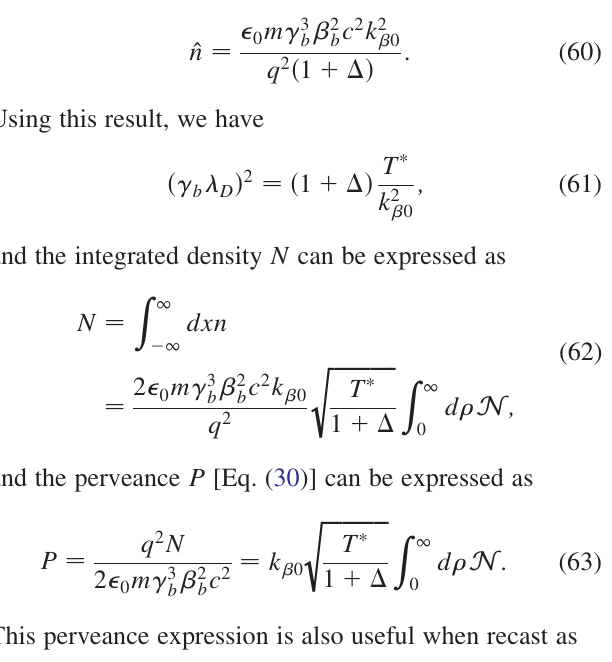
Þ calculated from the (cid:10) b D